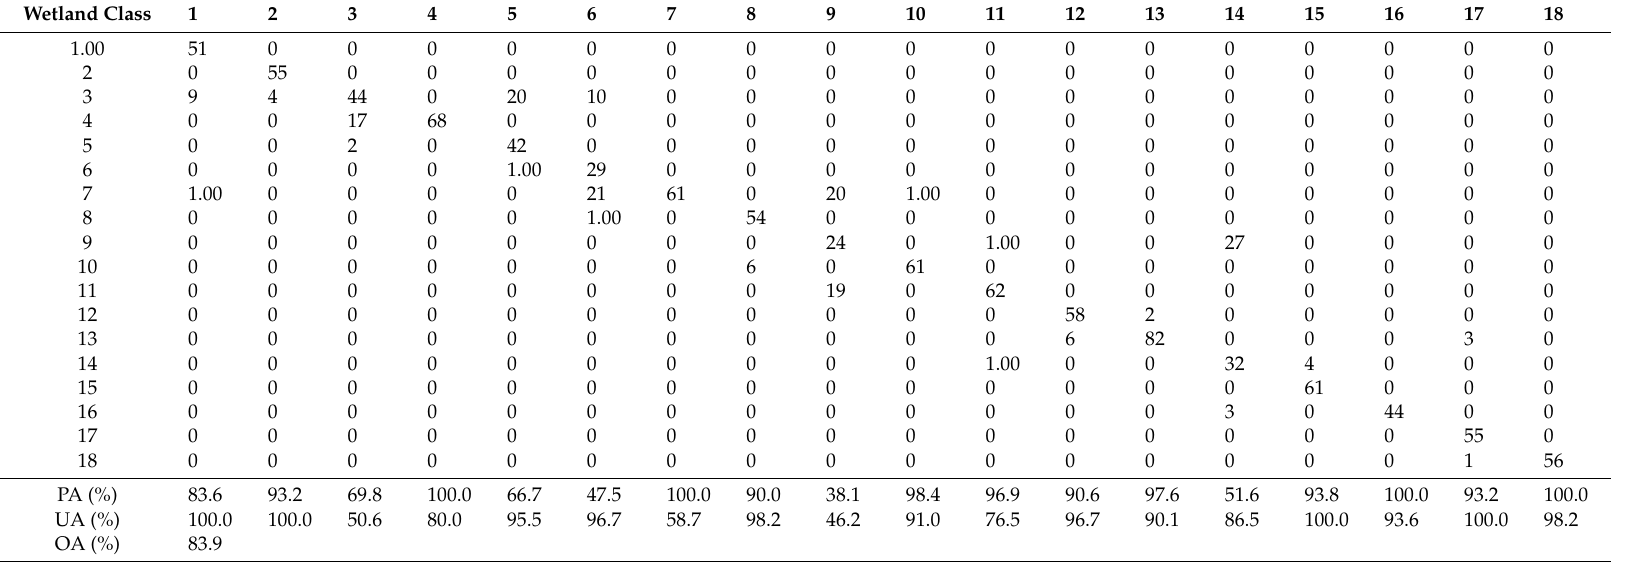
Table 7. Pixel-based ML classification class confusion matrix (pixel-counts) for genus-level wetland classes and aquatic habitats (three-layer stack). PA, UA, and OA are producer’s, user’s, and overall accuracy, respectively. See the legend in Figure 5a for additional information regarding the wetland class community composition. Wetland